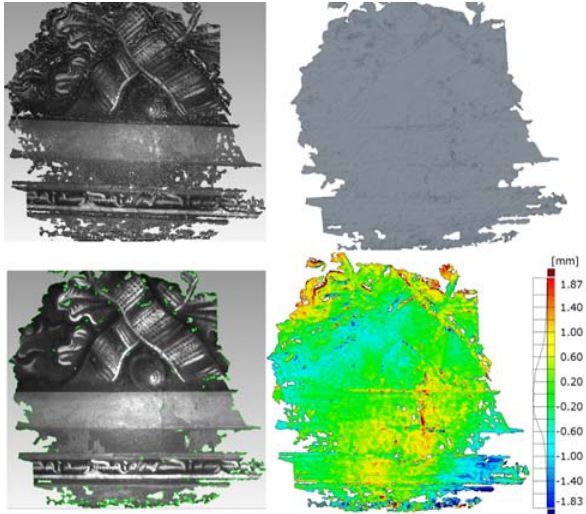
Figure 12. The point cloud (top-left), mesh (top-right), textured mesh (bottom-left) and deviation in mm from a plane fitted to point cloud (bottom-right).